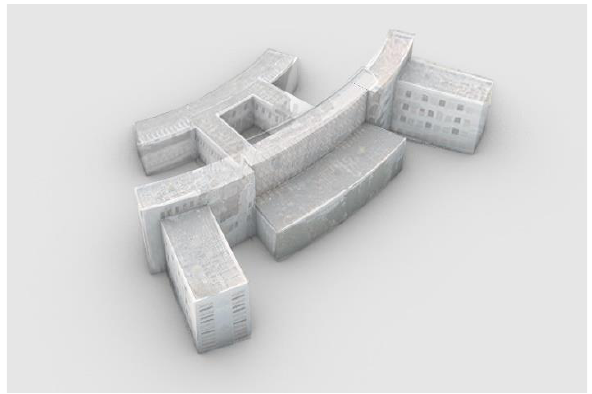
Figure 17. 3D model.